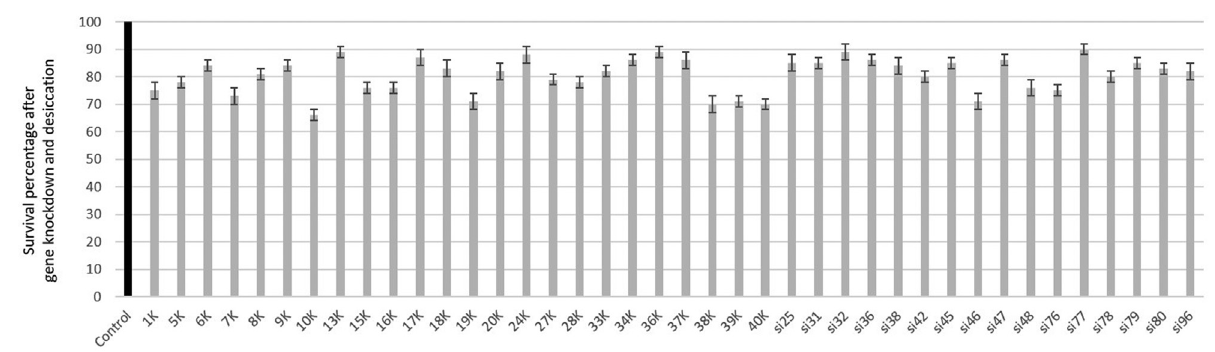
Figure 4 - Identification of anhydrobiosis-related genes in P. superbus . All the 40 genes here indicated lead to statistically significant reductions >10% in survival percentage (z-test, p<0.05 compared to control group) after knockdown and desiccation.